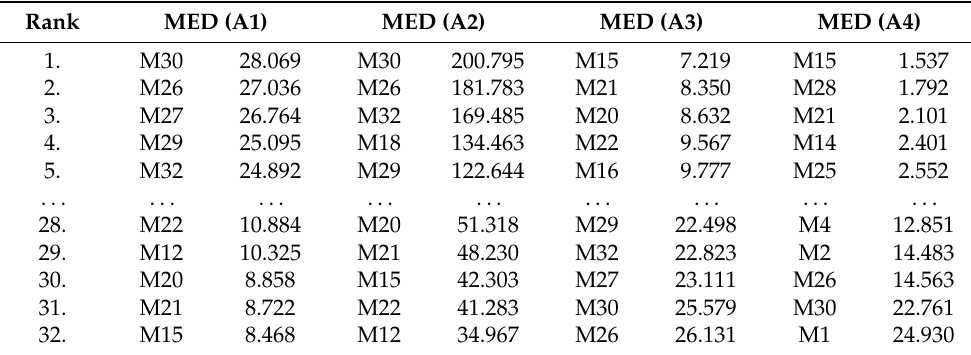
Table 6. The best and the worst rated municipalities within the terms of variants A1, A2, A3, and A4 throughout the entire monitored